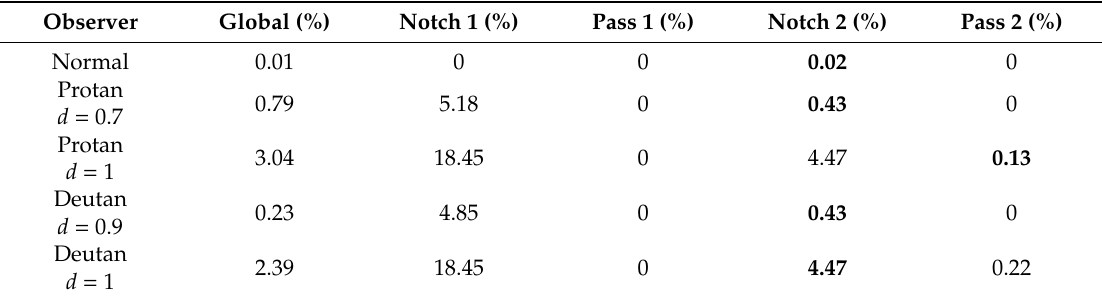
Table 2. Global percentage of filters of each type that produced a positive relative variation in NODC for each observer. The data for the filters of the same type as the one selected are shown in bold numbers. Observer